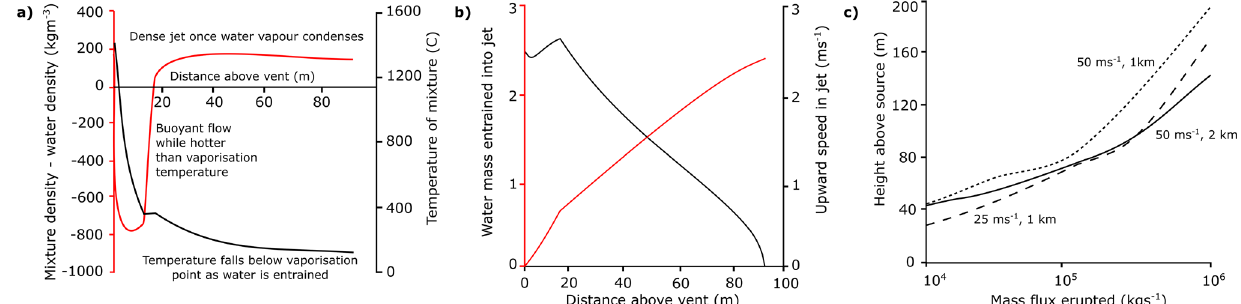
Figure 1. ( a ) Density of the jet relative to the ambient water (red line) and temperature of water-solid mixture (black solid line) calculated from the jet model described in the text; ( b ) entrained mass flux of water as a fraction of the mass eruption rate, (red line) and upward speed of the fountain (black line) as a function of distance above the vent, calculated from the jet model, for an eruption rate of 10 6 kg s − 1 , and eruption temperature of 1400 °C, from a vent at a depth of 2 km below the surface. ( c ) Maximum height of rise of a submarine fountain as a function of the erupted mass flux, for eruption speeds for 25 and 50ms − 1 at a depth of 1 km below the sea surface, and for 50ms − 1 at 2 km below the sea